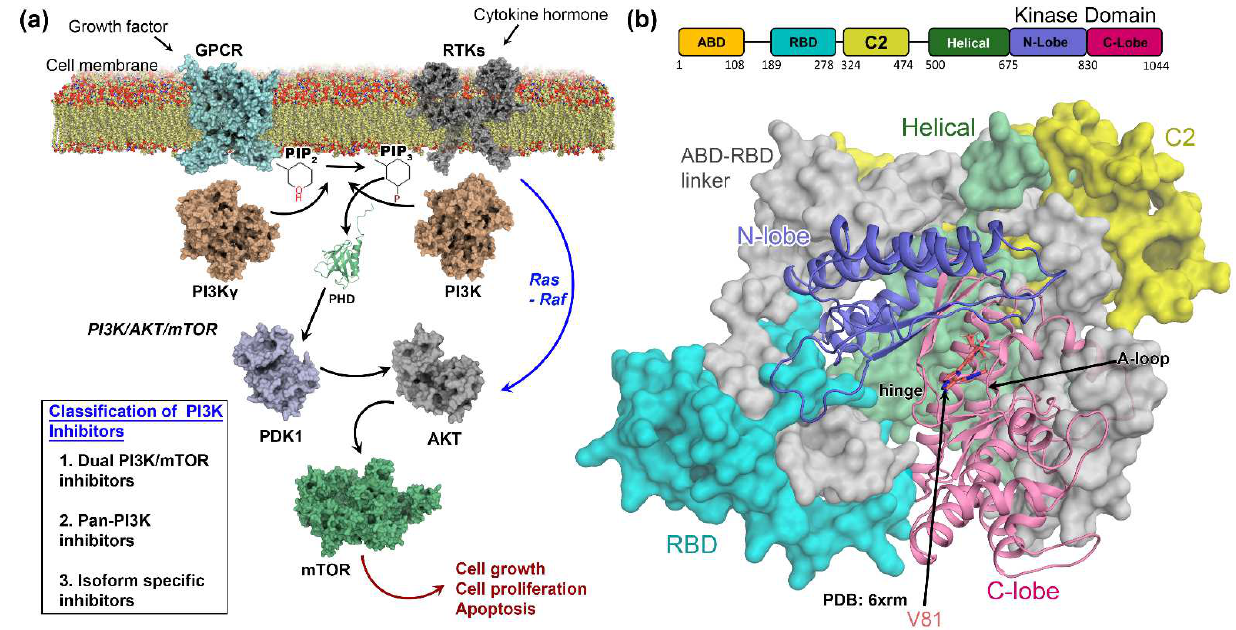
Figure 1. Canonical signaling and structural domain organization of PI3Kγ. ( a ) An overview of PI3Kγ-mediated AKT/mTOR signaling pathway. The activated mTOR is further involved in GC progression through the remodeling of TAM differentiation. The therapeutics available for targeting PI3K mediated pathways have been categorized into three major classes, as illustrated in the inset box. ( b ) The overall crystal structure of human PI3K γ (PDB: 6xrm) consists of four domains: an RBD domain in cyan, a C2 domain in yellow, a helical domain in green, and a kinase domain colored in slate (N-lobe) and pink (C-lobe), respectively. The inhibitor V81 bound to the hinge is shown in